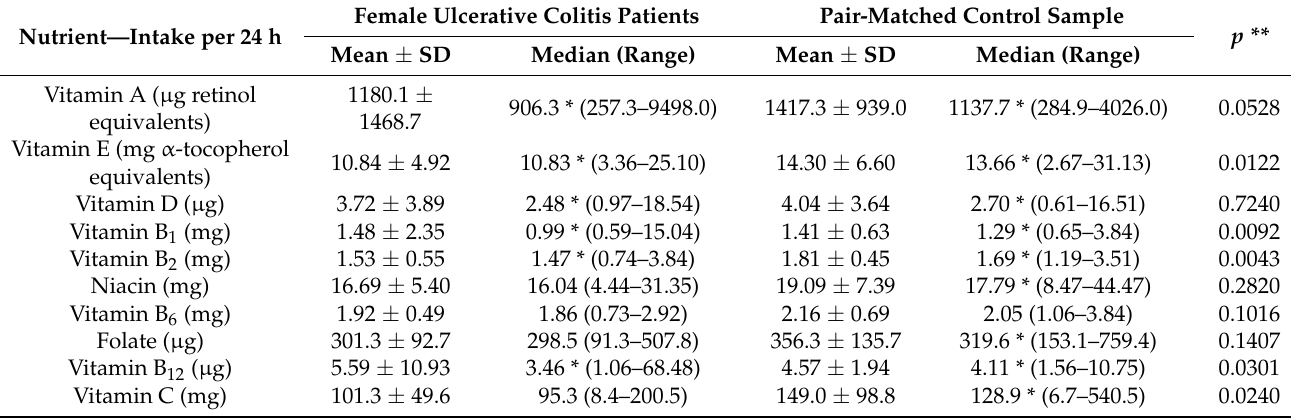
Table 5. The vitamins intake in the studied Polish female ulcerative colitis individuals, in comparison with a pair-matched control sample.